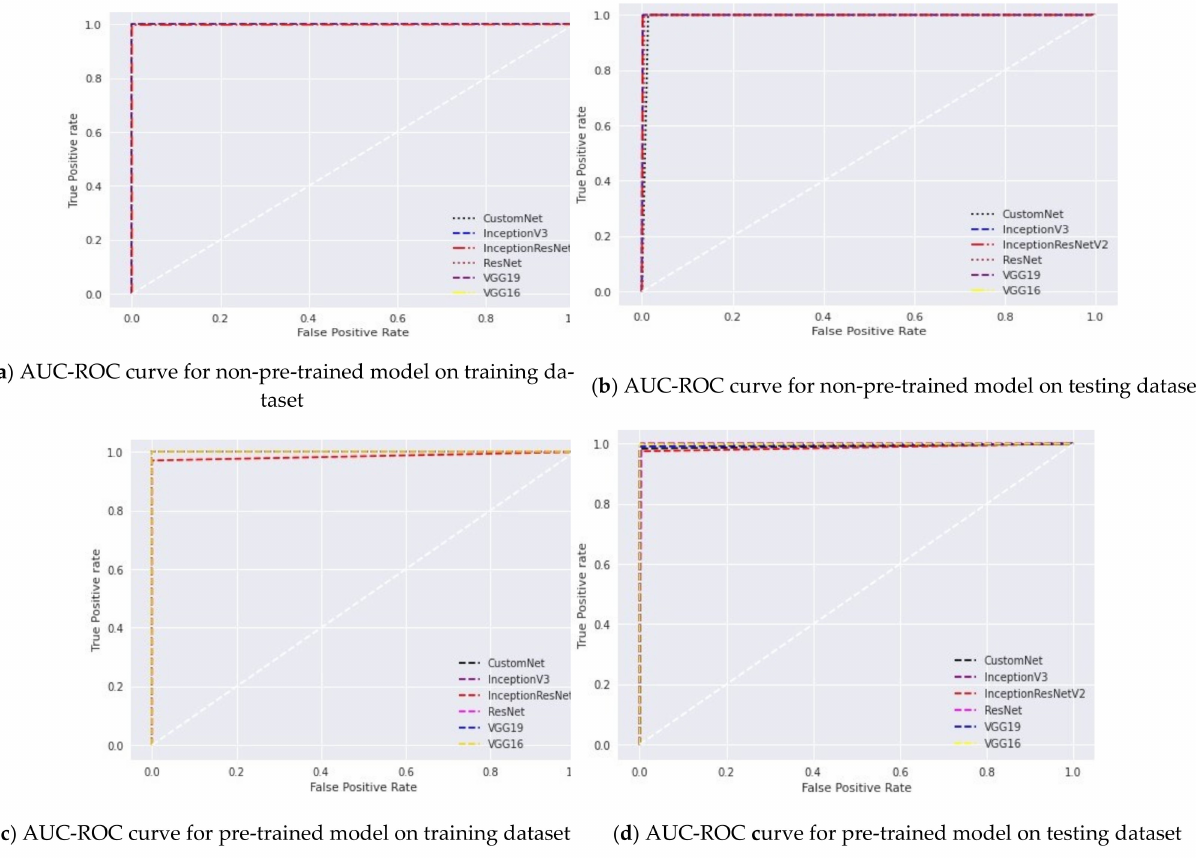
Figure 6. AUC-ROC curves of six classifiers on the training and testing